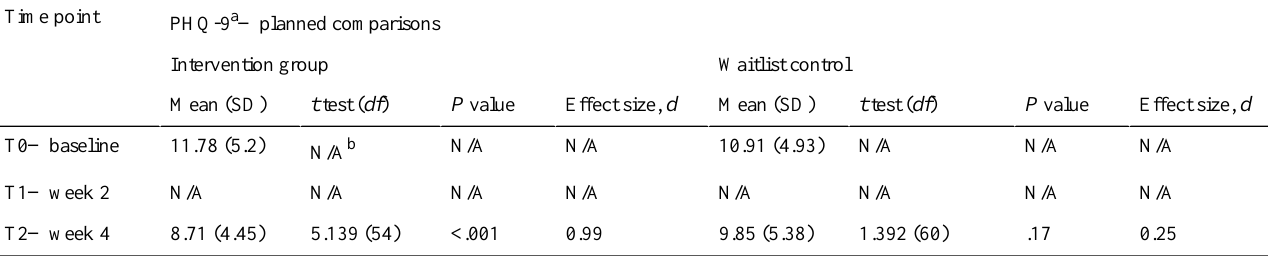
Table 7. Mean, SD, and planned comparisons on Patient Health Questionnaire scores over the duration of the intervention (T0, T1, and T2) in the intervention and waitlist control